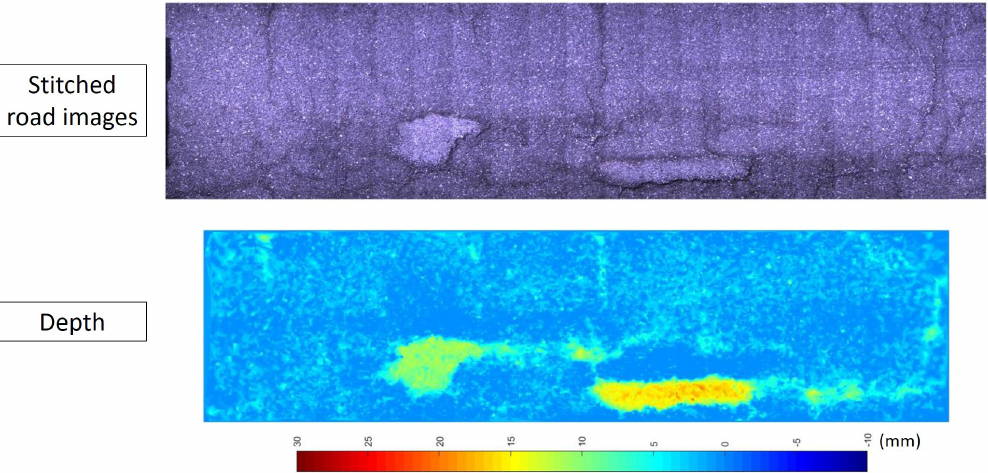
Figure 17. The qualitative 3D reconstruction result for a section of road using the proposed technique. Top: a road surface image stitched by 20 consecutive images captured. Bottom: A colormap image for the depth ( { G } Z direction) values of reconstructed X r using the proposed 0:20